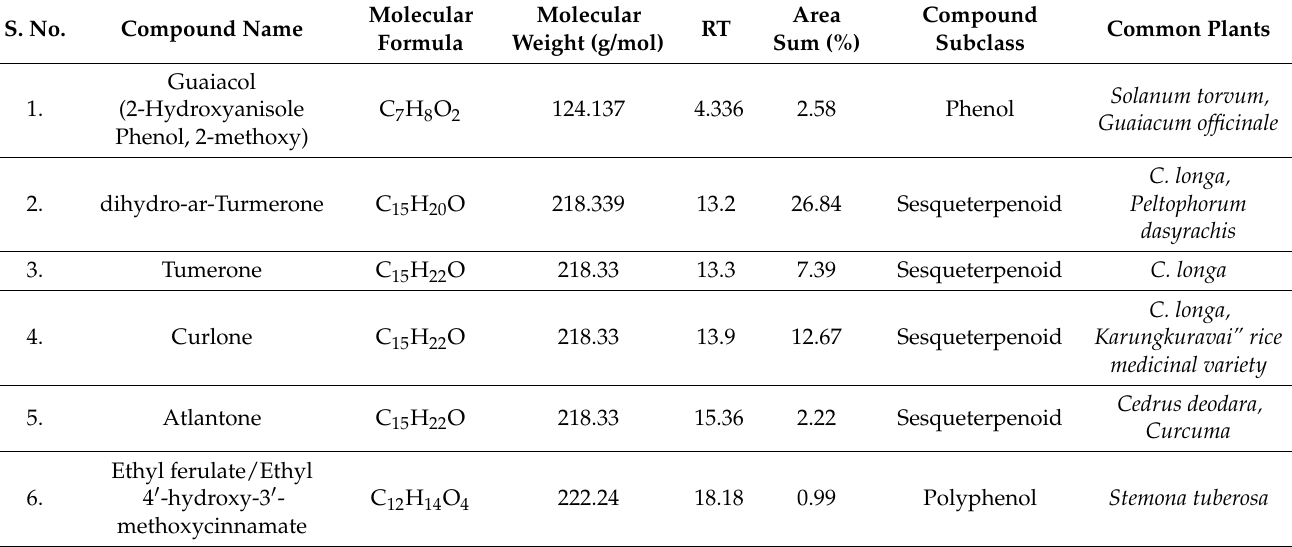
Table 3. Important bioactive compounds in EECl as analyzed by